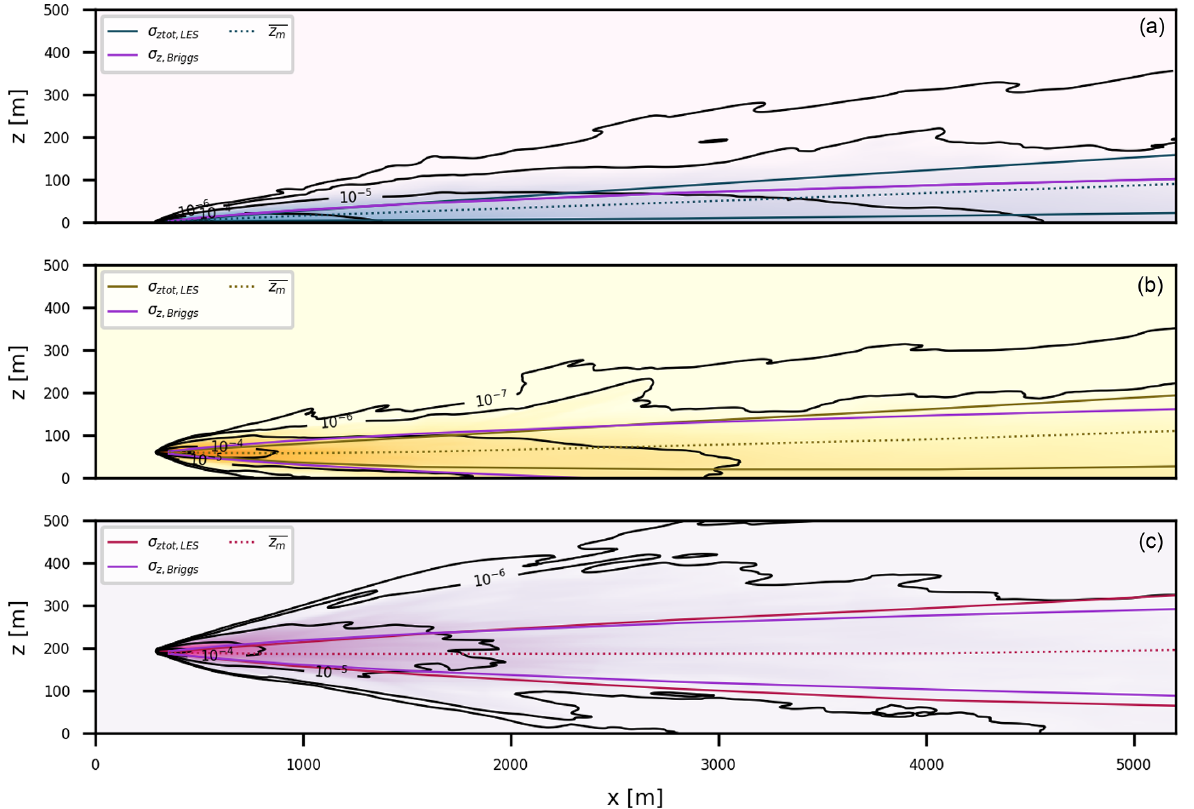
Figure 6. Time-averaged x – z cross-section of the LES plume at (a) 0m, (b) 60m, and (c) 190m height. The concentration fields are averaged over half an hour. The isolines connect the areas with the same concentration shown here (in gkg − 1 ). Also plotted are the plume edges of the Gaussian plume (assuming Briggs diffusion coefficients) and the LES plumes. Centerlines z m are plotted as dashed lines.